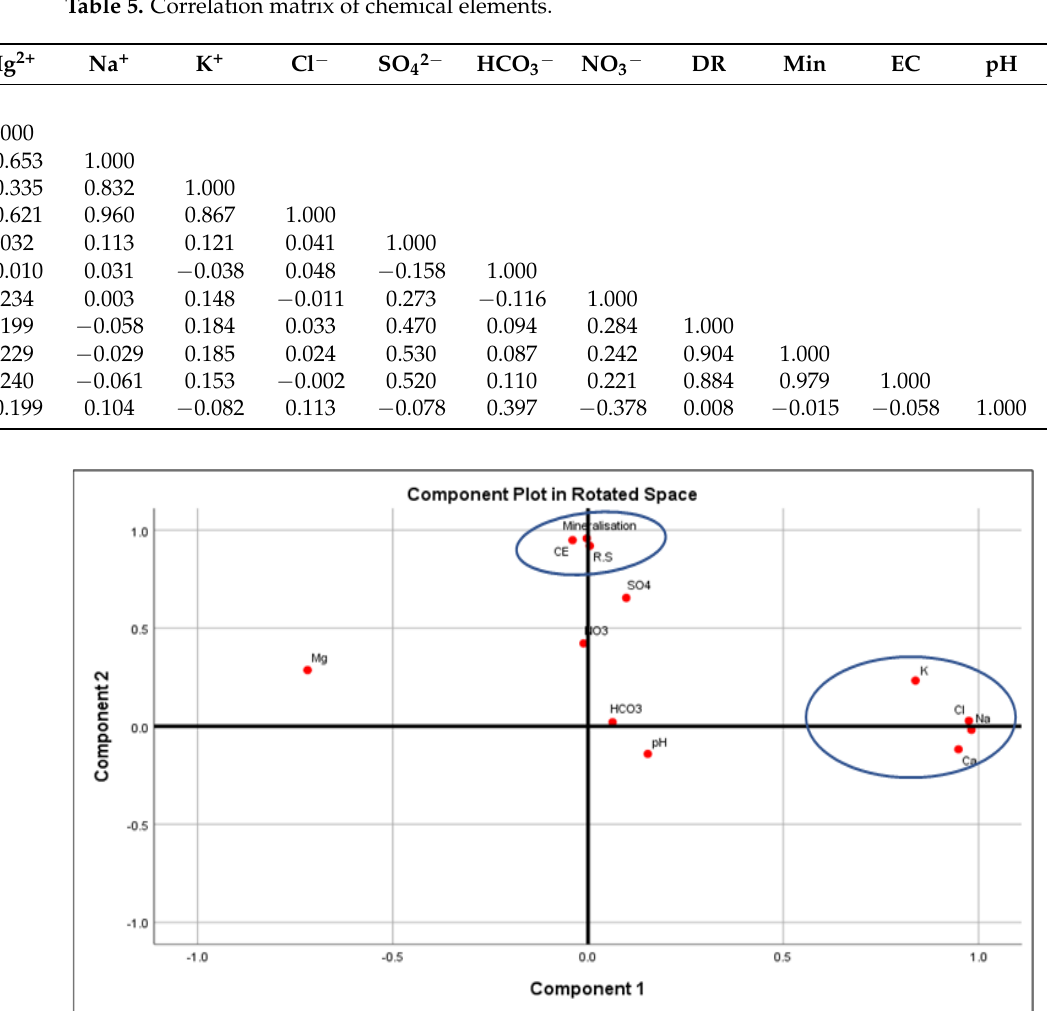
Table 5. Correlation matrix of chemical elements.